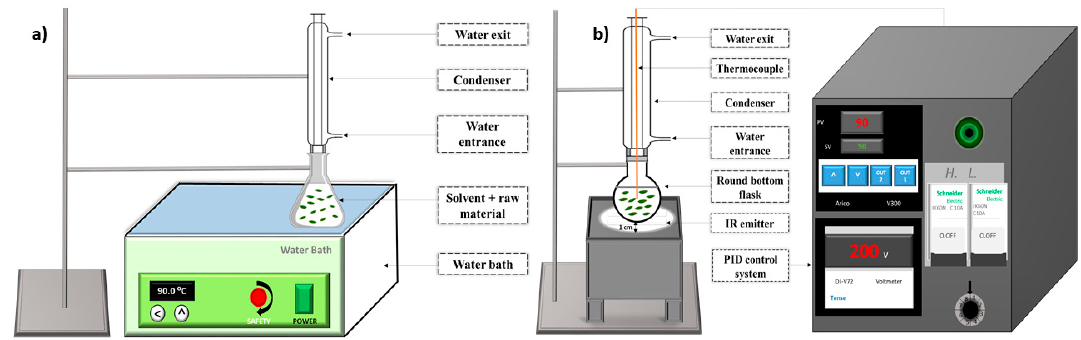
Figure 1. Instrumental setup for ( a ) water bath (WB) and ( b ) infrared apparatus (IR).